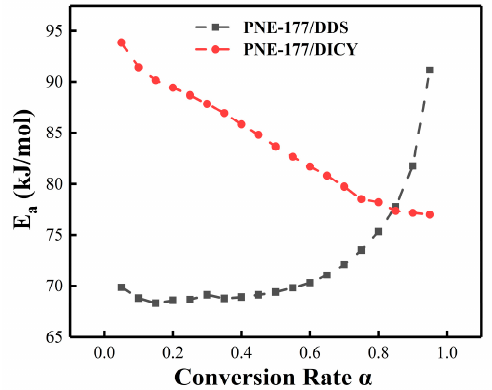
Figure 4. E a vs. α curves of different curing agent systems.